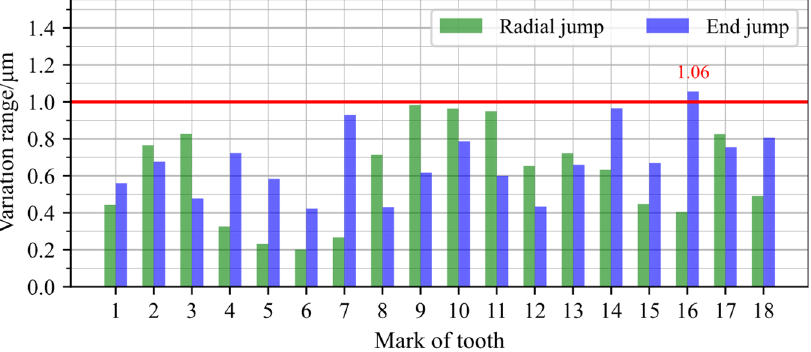
Figure 17. Statistical chart of the three test results of experimental group 2 after turning teeth.